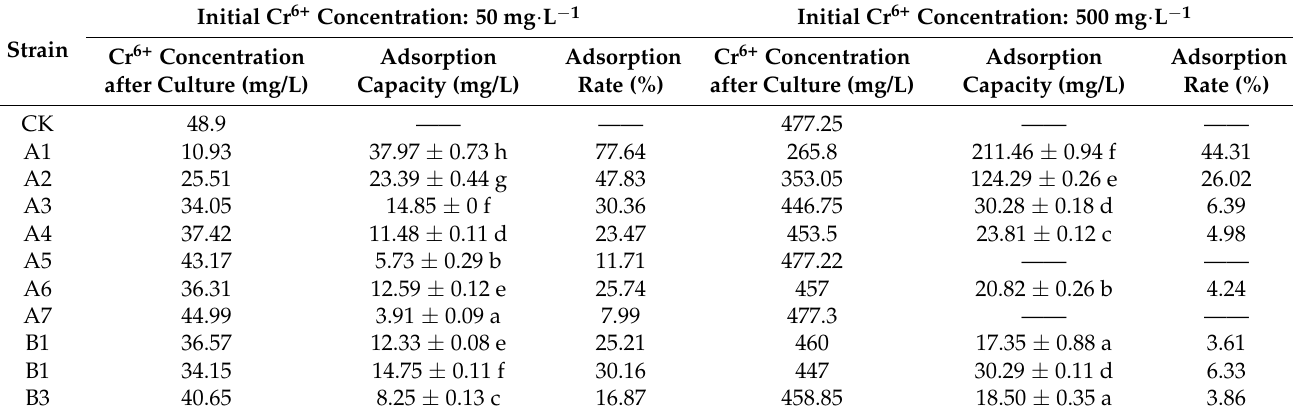
Table 1. Screening of chromium tolerance of A. niger strains.